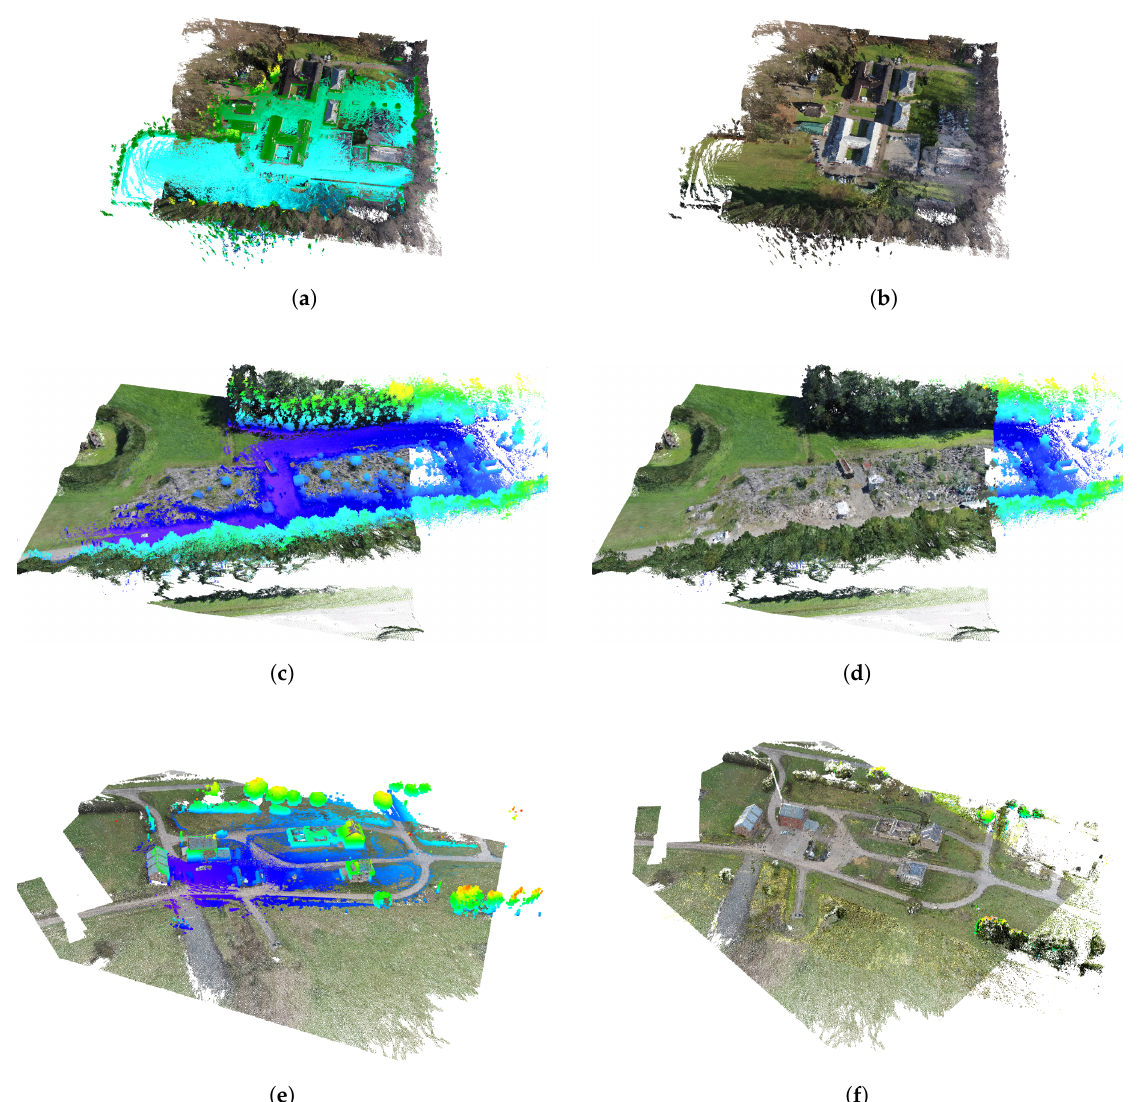
Figure 17. Color transformation from the UAV point cloud to the UGV point cloud. The different scenarios are represented as follows: Dovo ( a , b ), Rubble ( c , d ) and Village ( e , f